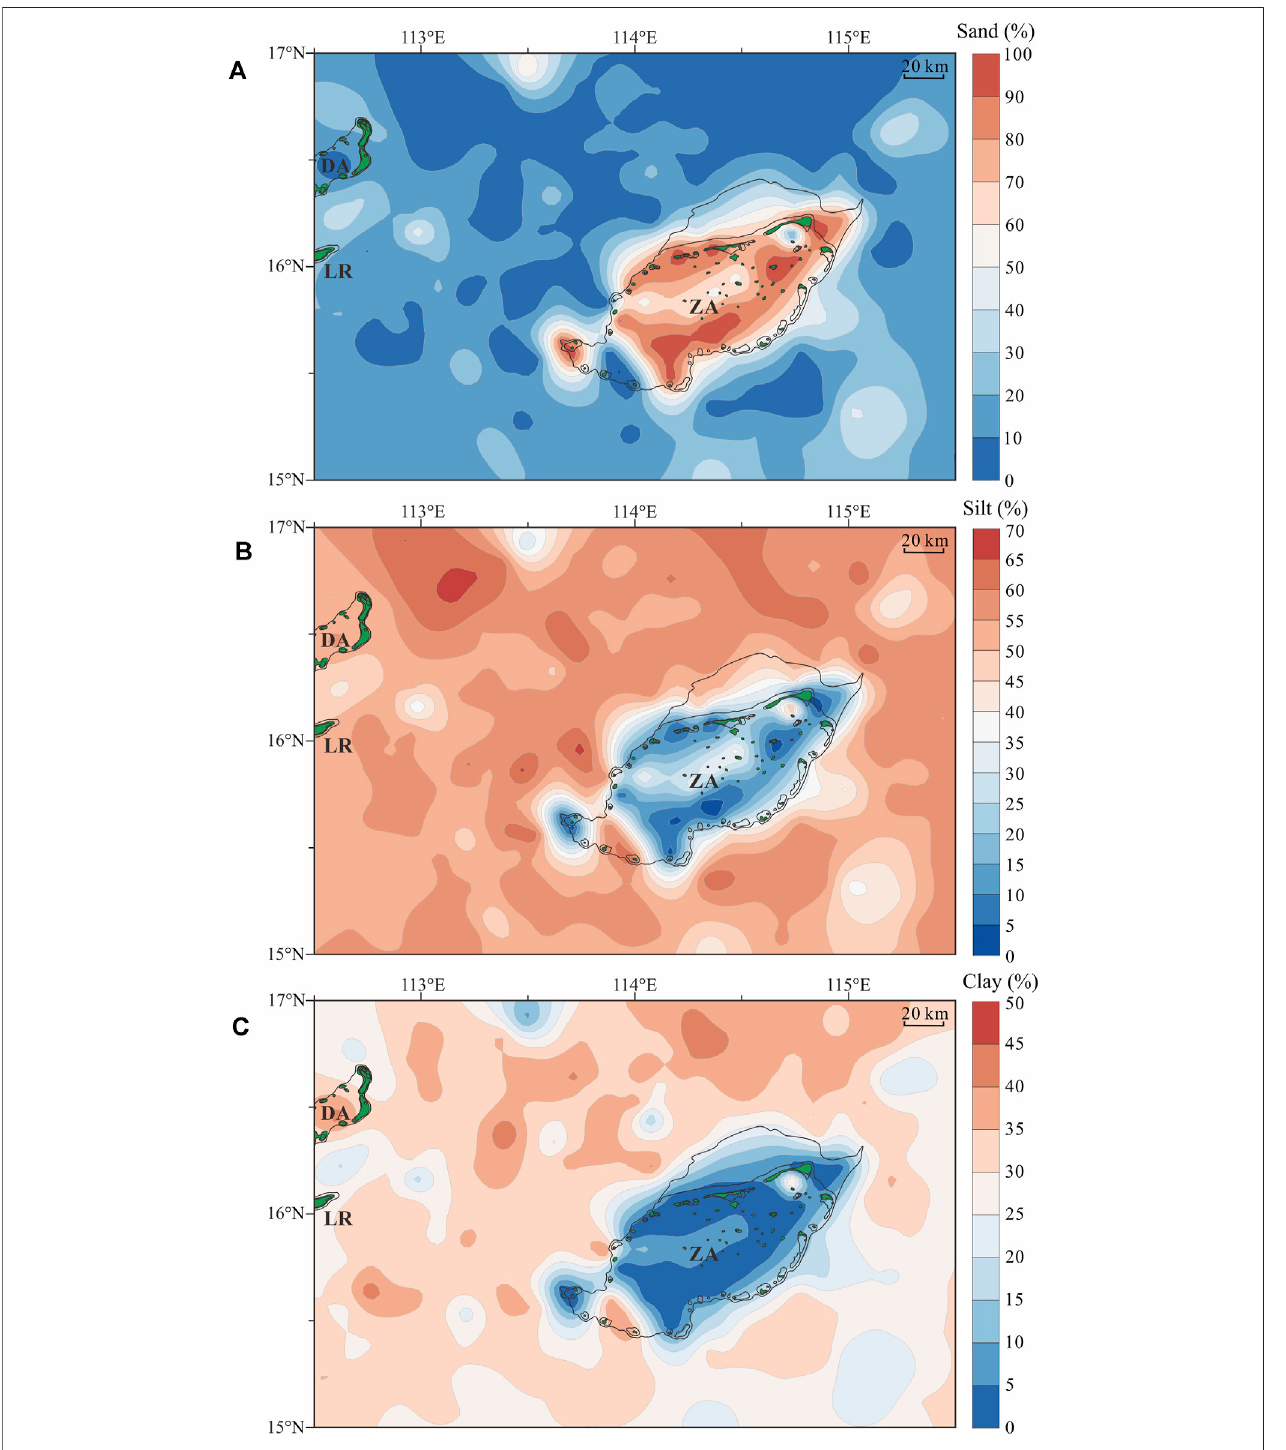
FIGURE 2 | Spatial distribution of sediment contents in the study area, including (A) sand, (B) silt, and (C) clay.